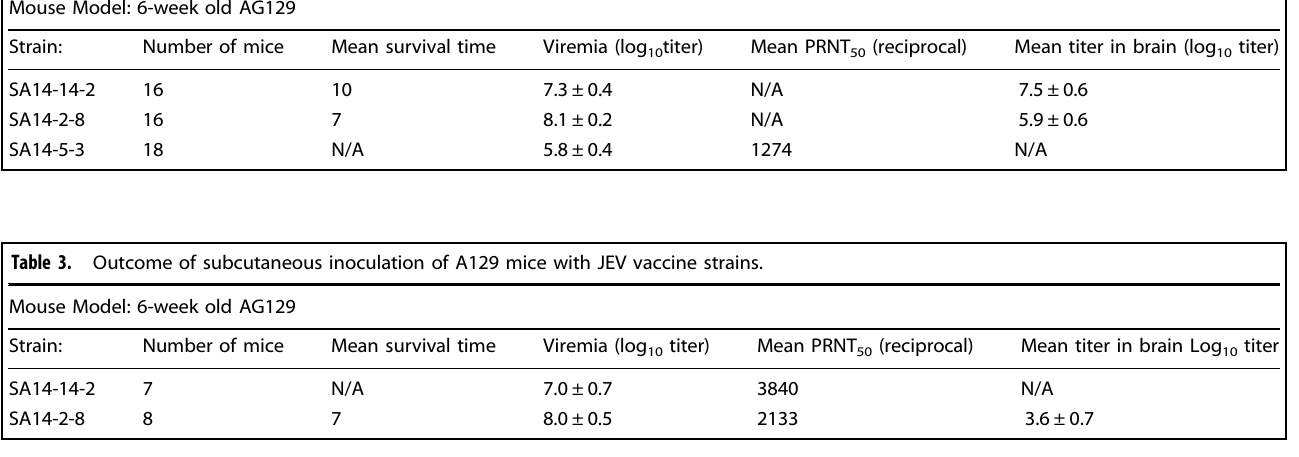
Table 2. Outcome of subcutaneous infection of AG129 mice with JEV vaccine strains. Mouse Model: 6-week old AG129 Strain: